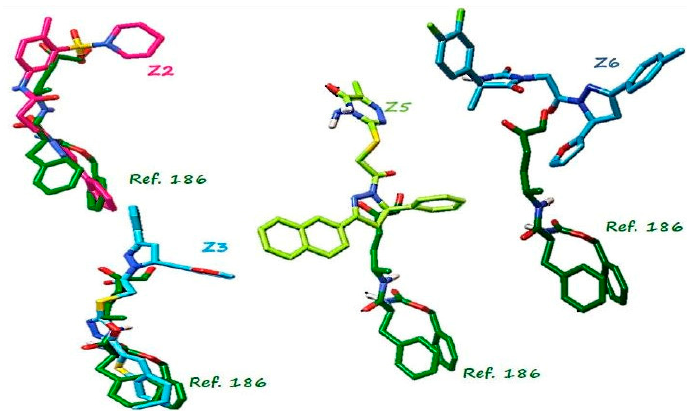
Figure 3. Analysis of coupling postures between the pose of ligand 186 interacting on the catalytic site (green) and compound Z2 in pink, Z3 in light blue, Z5 in green lemon and Z6 in blue, alignment of structures performed with AutoDock Tools programm.